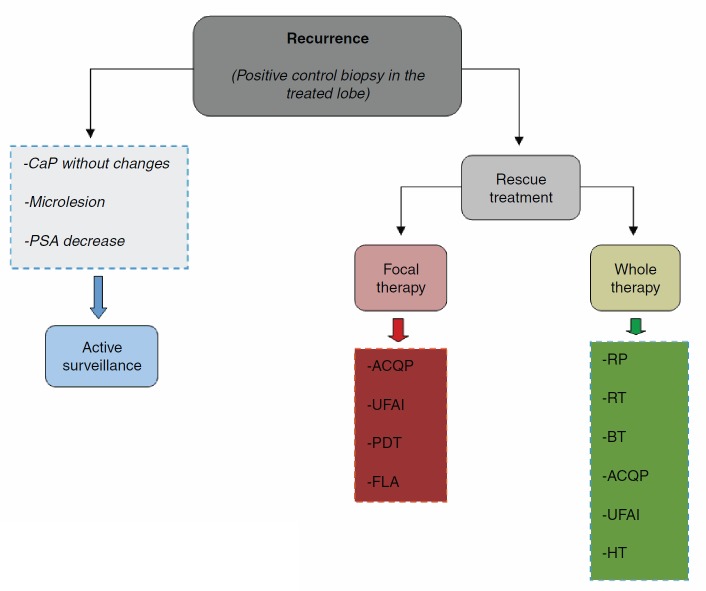
Treatment algorithm.